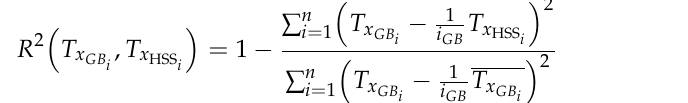
and applied force and applied force F z (cid:3276)(cid:3291)(cid:3291)(cid:3287) appl appl